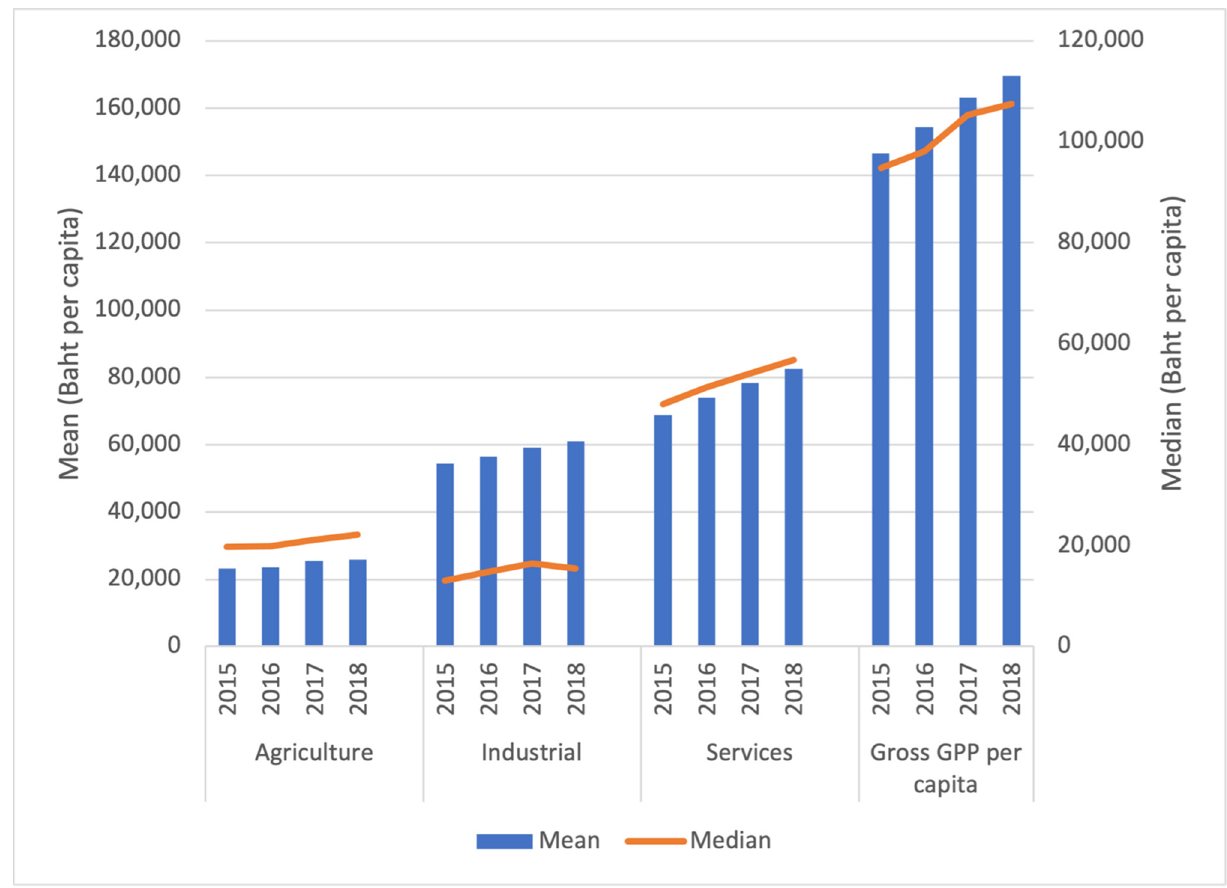
Figure 3. Mean and median of provincial economic variables in Thailand during 2015–2018. Note: $1 US Dollar = 33.89 Baht (as of 8 October 2021).